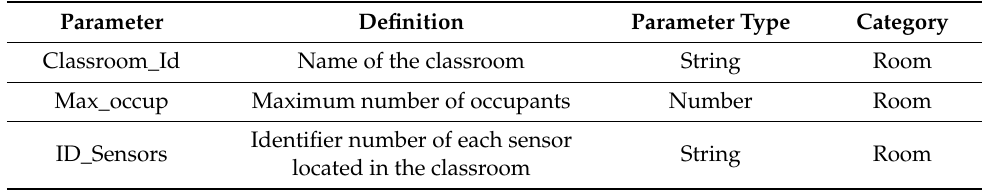
Table 2. Shared parameters used in the